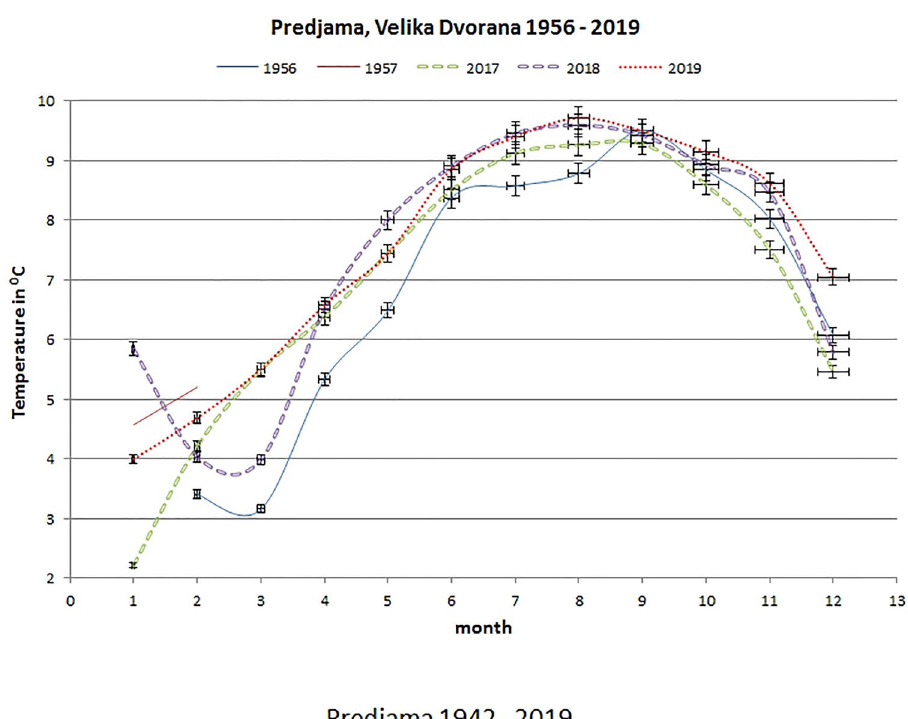
Fig. 6 Mean annual air temperature (in °C) in Velika Dvorana (Predjama Cave) and outside the cave for the period 1942–2019. Historical data are from [11,